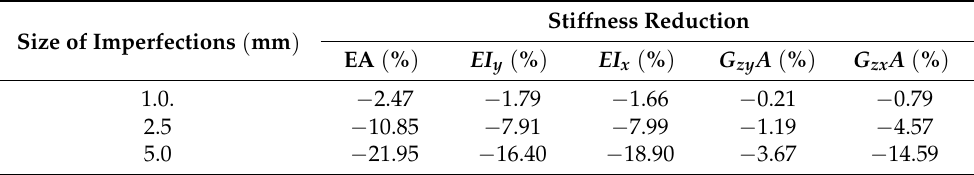
Table 3. Stiffness reduction of a Z profile with an elongation of 100 mm due to bending about the horizontal axis for (i) case, depending on the size of imperfections.